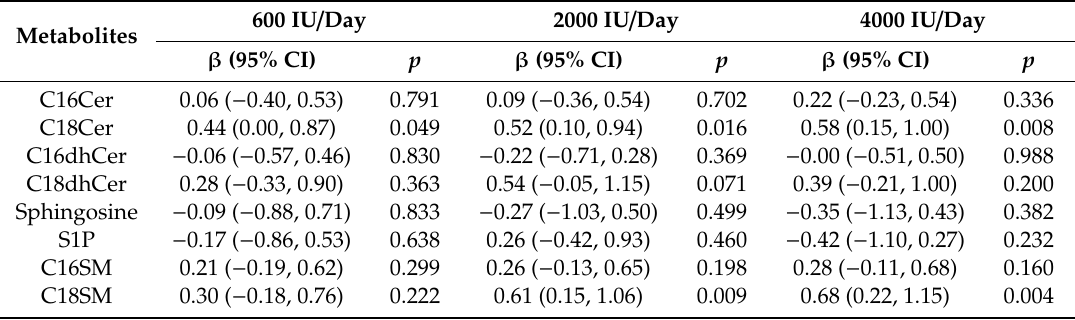
Table 2. Adjusted associations between sphingolipids and vitamin D 3 supplementation